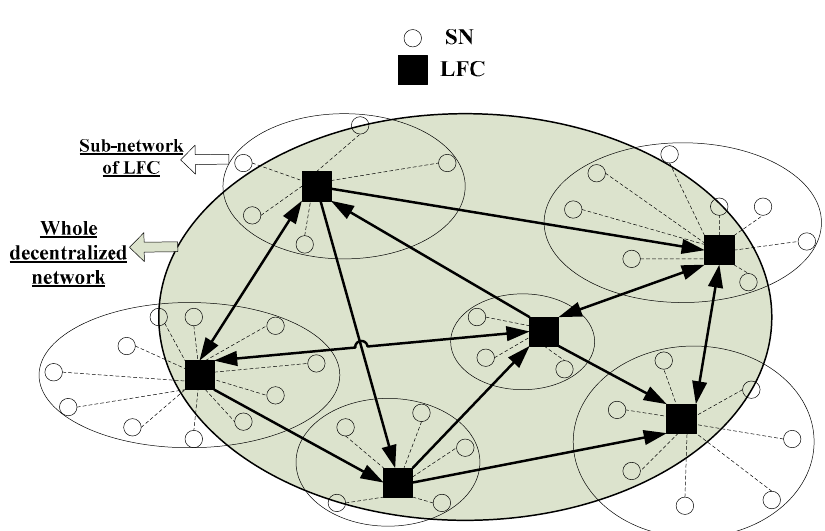
Figure 1. Diagram for decentralized sensor network. ○ and █ denote SN and LFC, solid lines with arrows denote directed connections between LFCs, the dotted lines denote connections between LFC and its subordinate SNs.